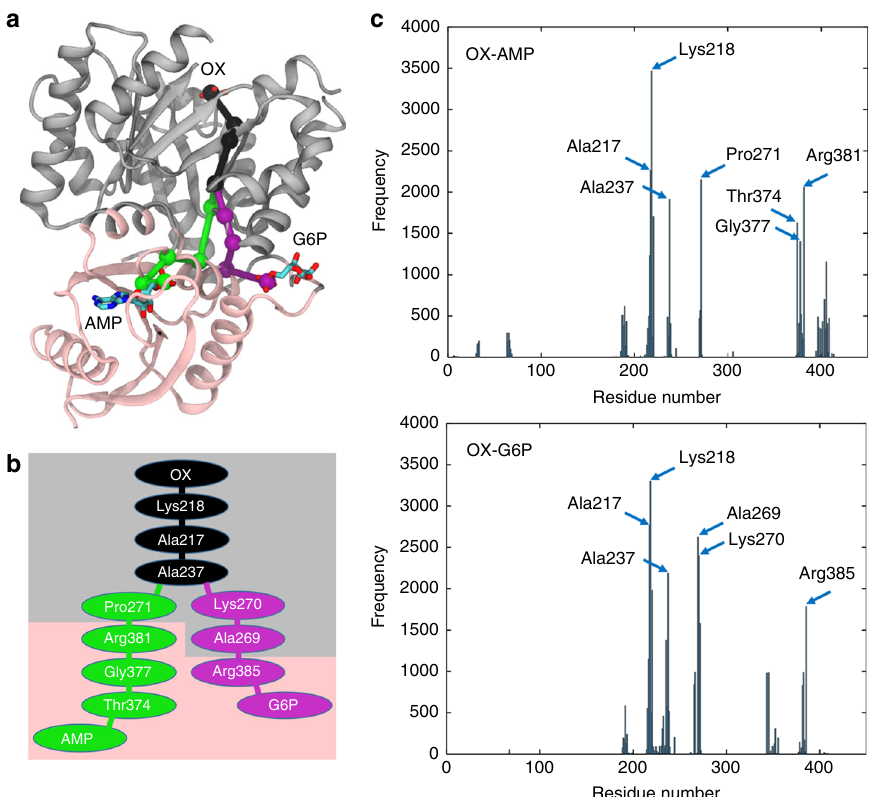
Fig. 4 Allosteric pathways between the catalytic site and the two allosteric sites. a The allosteric pathways of OX-AMP (green) and OX-G6P (purple) share three common residues, namely Ala217, Ala237 and Lys218 (black spheres). The shared portion of the pathway is coloured black. The protein is drawn in ribbon and coloured according to community analysis. Note that the lid B domain is not shown for clarity. b A schematic shows the two allosteric pathways and the key participating residues. The residues could be grouped in two different communities, coloured in grey and pink. c Histograms of the key residues involved in the pathways, showing the frequency at which a particular residue was identi fi ed in one of the 4000 calculated pathways. The allosteric pathways were extracted from the MD simulations using WISP dynamic network